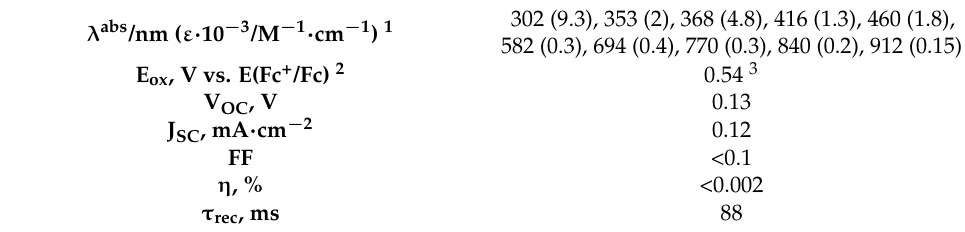
Table 1. Optical, redox and photovoltaic characteristics of complex 2